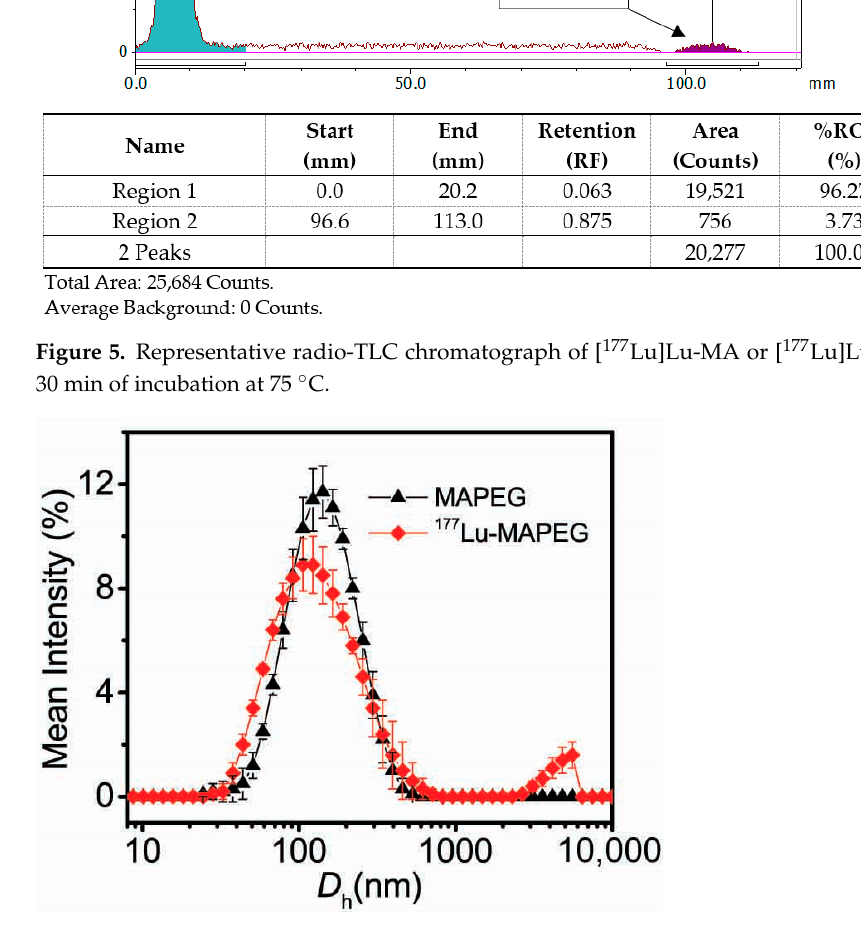
Figure 6. Size distribution of MIONs before (MAPEG) and after ( 177 Lu-MAPEG) radiolabeling with 177 Lu.